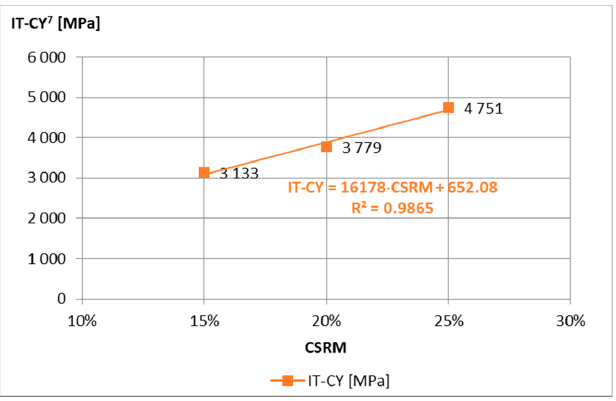
Figure 7. IT-CY stiffness modulus of ACCR with “B” CSR mortar samples Ø100 mm × 63.5 mm depending on the amount mortar, at the temperature of 5 °C, after 7 days of curing.